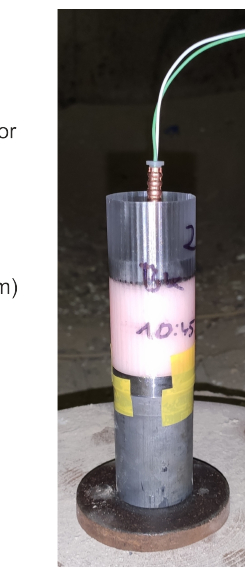
Figure 4. Experimental setup for determining brisance using the Hess method.